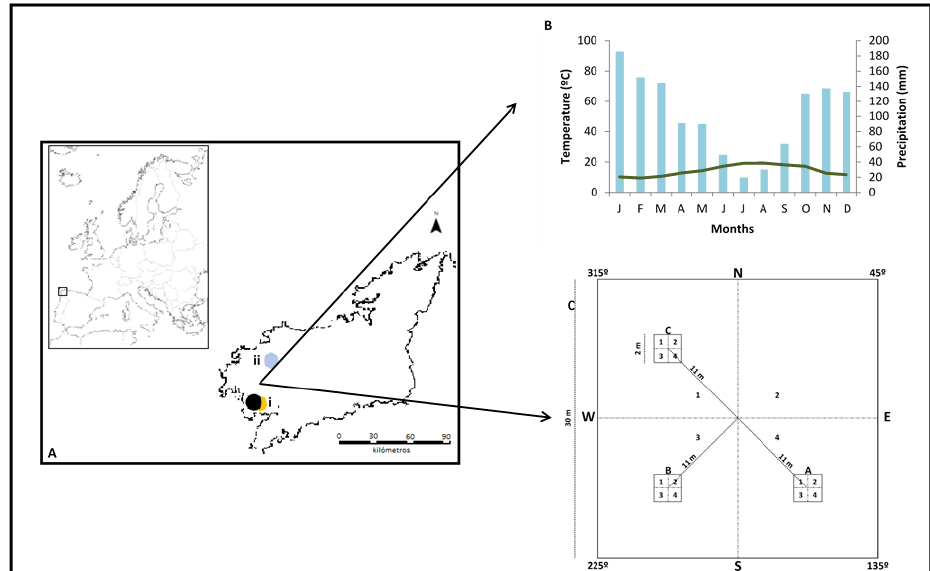
Figure 1. ( A ) Map of Europe with the situation of the province of A Coruña where the two sampling areas stand in: (i) Monte Pindo, where the black circle is the area a ff ected by the fire and the orange circle the control zone and (ii) Brañas of Reveirugas. ( B ) Ombrothermic diagram of the studied area. ( C ) Scheme of the plot of 30 m × 30 m, the 2 m × 2 m subplots, and the 1 m × 1 m units.